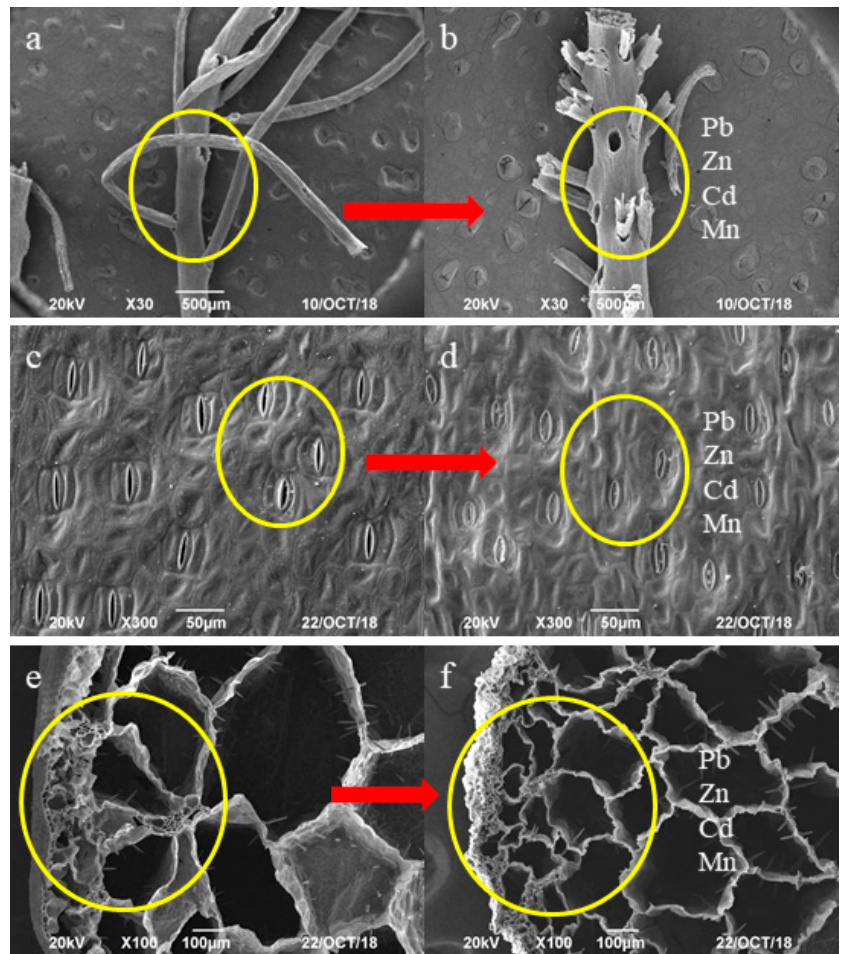
Figure 1. Scanning Electron Microscopy (SEM) images of ( a ) the roots, ( c ) the leaves, and ( e ) the stolons before the experiment and ( b ) the roots, ( d ) the leaves, and ( f ) the stolons in the karst water after uptake of Pb, Zn, Cd, and Mn.